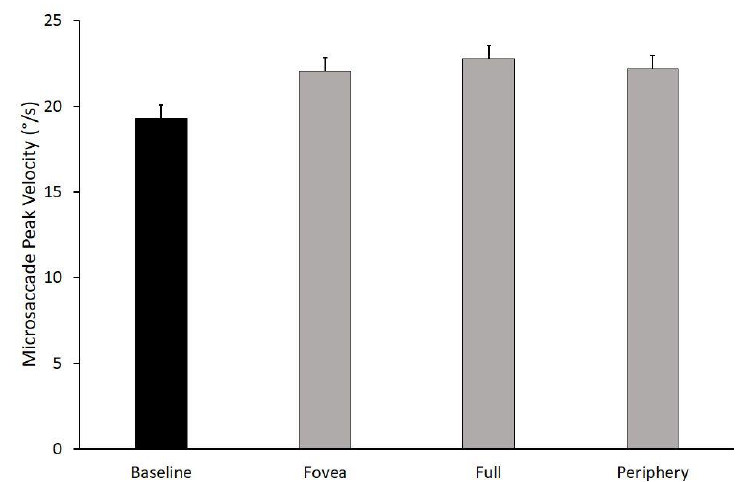
Figure 2. Frequency histograms of microsaccades peak velocity in all stimuli. Grey histograms represent optic flow stimuli, black histogram represents baseline. Data are reported as mean ± SE.